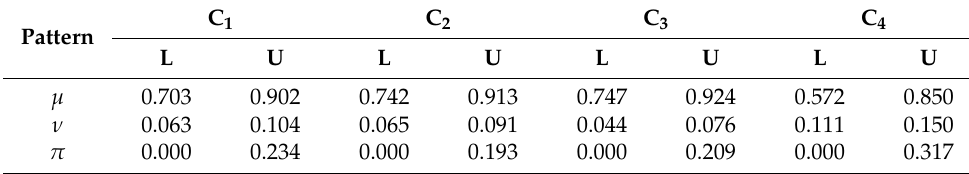
Table 11. Coordinates of the reference object for criteria C 1 –C 4